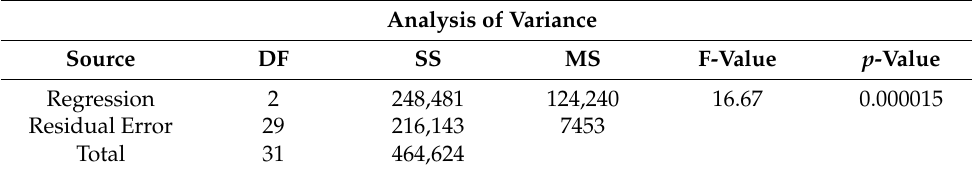
Table 5. The regression analysis between treatments and number of days using Minitab software.